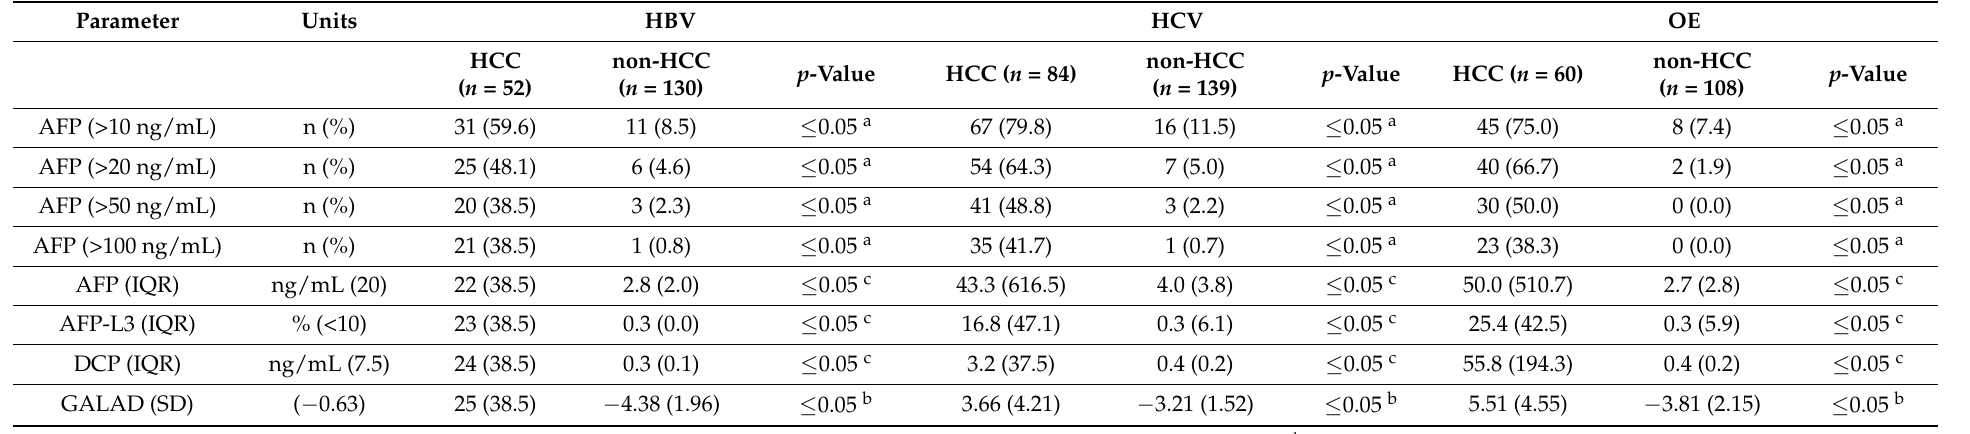
Table 3. HCC Serobiomarker of HCC group and non-HCC group for HBV, HCV and